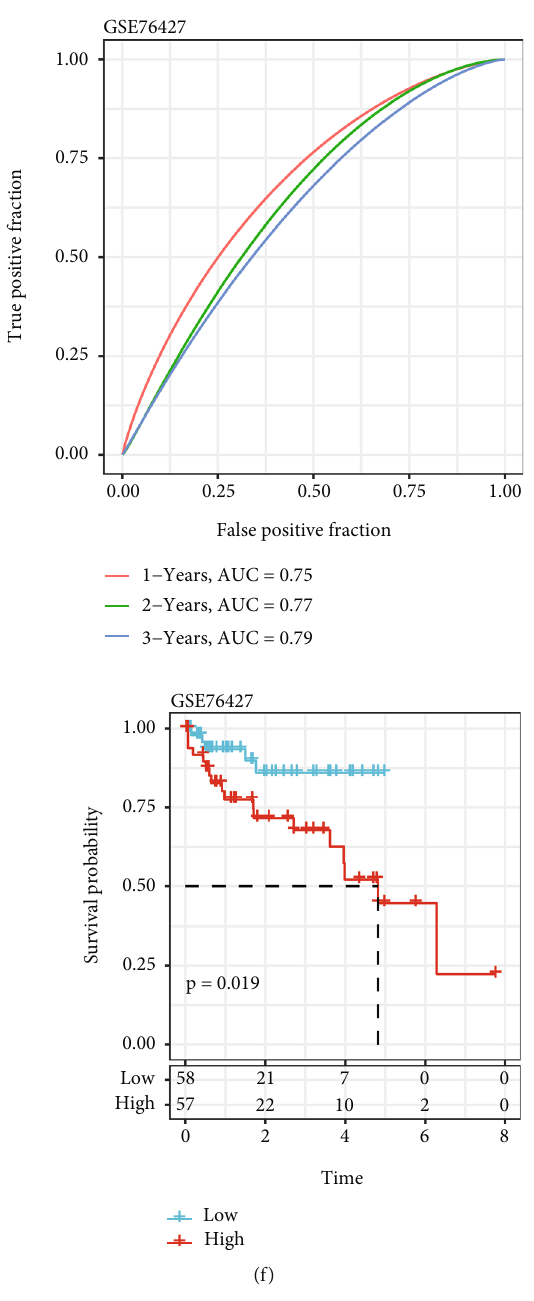
Figure 5: CSRS estimation, validation, and prognostic prediction analysis. (a) CSRS, overall survival time, alive status, and senescence- associated genes. (b) CSRS-based ROC curve and AUC curve comparisons in the TCGA-LIHC cohort. (c) CSRS-based ROC curve and AUC curve comparisons in the TCGA-LIHC cohort. (d) Overall survival time of high and low risk score groups in the ICGC-LIHC cohort. (e) ROC curve and overall survival time of high and low risk score groups in the GSE14520 cohort. (f) ROC curve and overall survival time of high and low risk score groups in the GSE6427